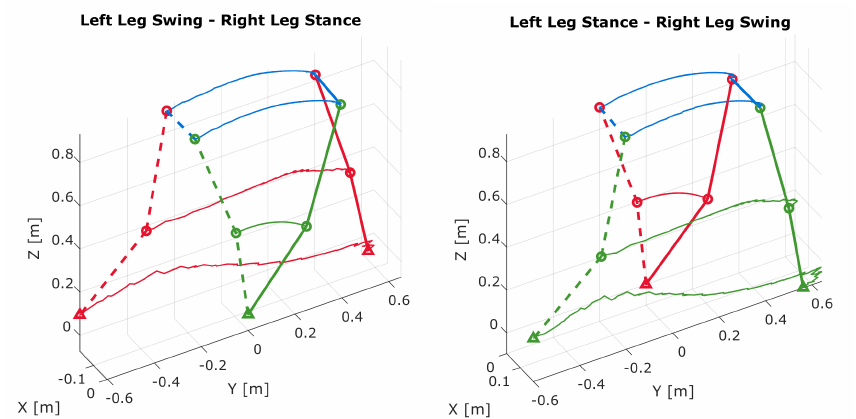
Figure 13. Forward kinematics of skeletal model between toe-off and heel-strike: ( left ) Left limb swing and right limb stance. ( right ) Right limb swing and left limb stance. Dashed lines refer to the start of the swing phase (toe-off) and solid lines refer to the end of swing phase (heel-strike).